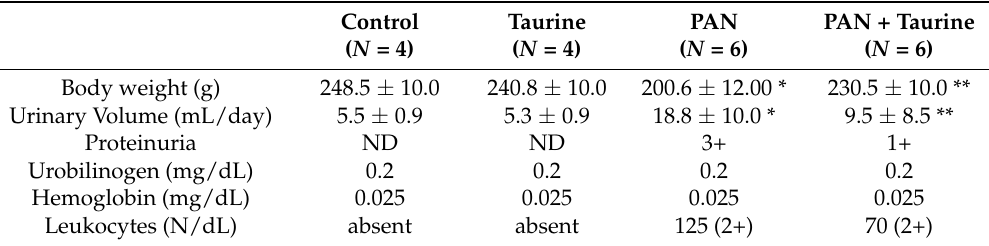
Table 1. Metabolic and urinary data of puromycin (PAN) nephrotic rats with either taurine (TAU) or no TAU